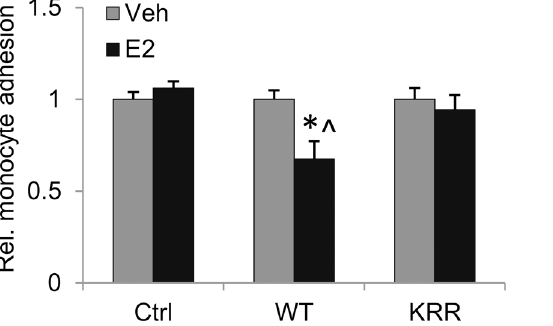
Fig 7. Rapid signaling through ER α is required for E2-dependent inhibition of monocyte adhesion to ECs. Relative counts of adherent U937 human monocytes to WT or KRR stable hECs +/- 10 nM E2, normalized to counts +Veh. * : different from WT+Veh, p. < 0.05, ^: p. 0.06 versus